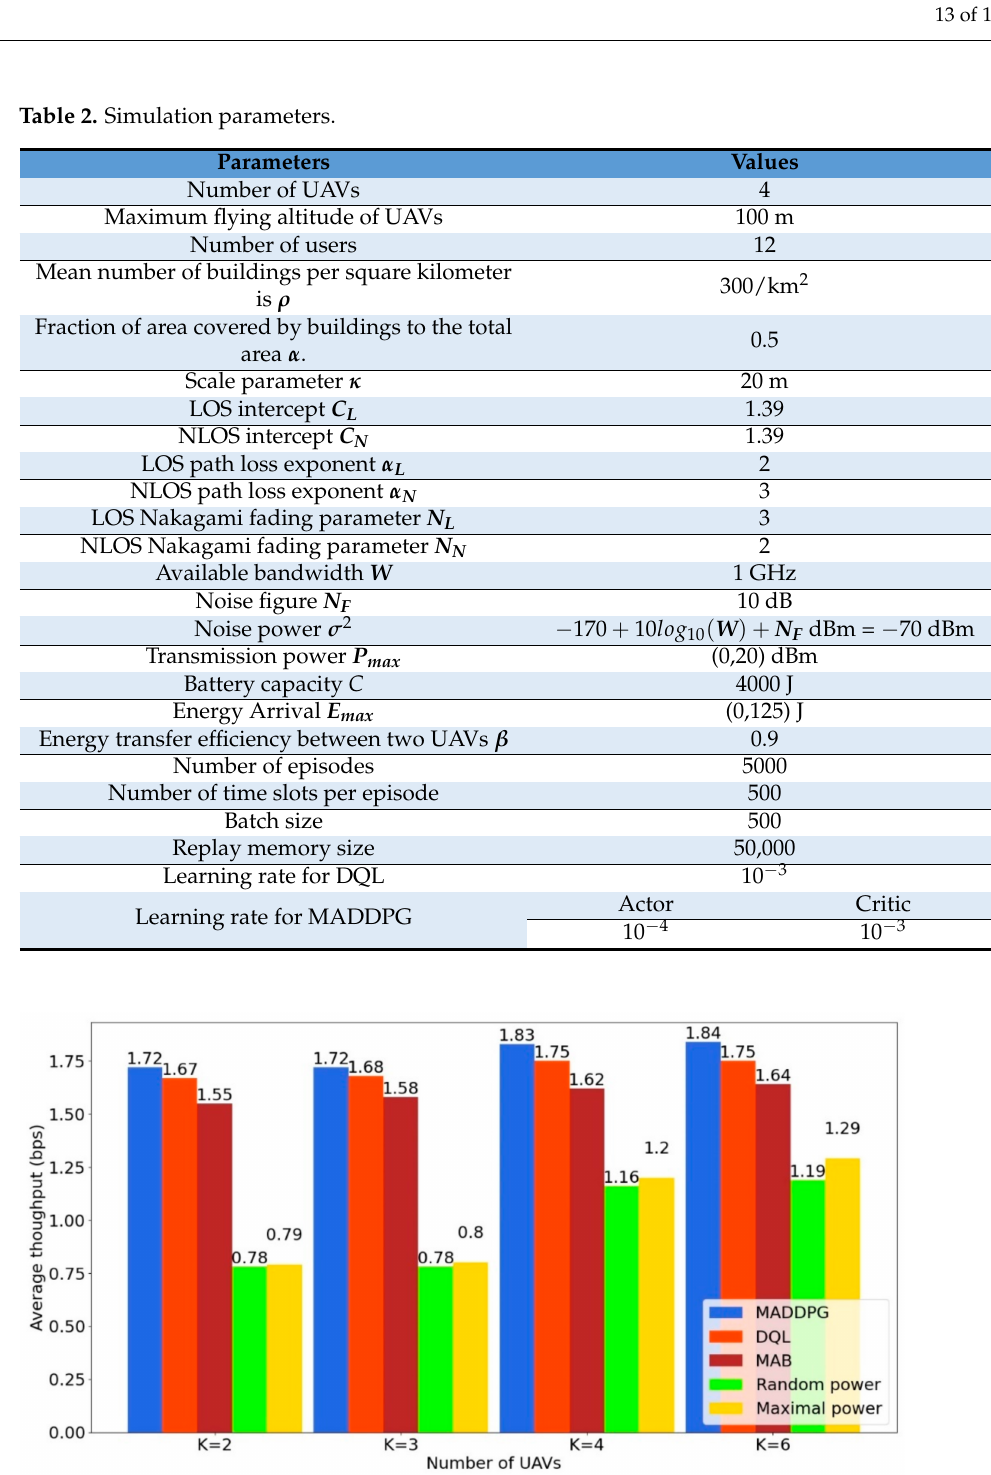
Figure 3. Average throughput as a function of the number of